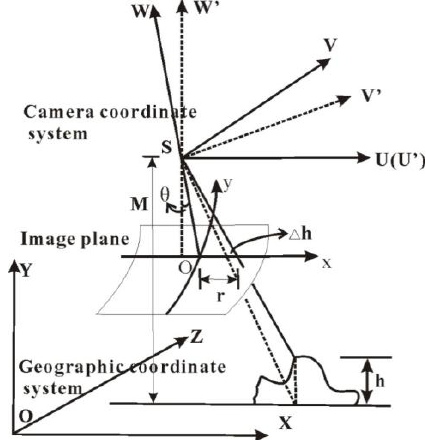
Figure 1. The imaging geometry of declassified intelligence satellite photography (DISP) from the CORONA mission.